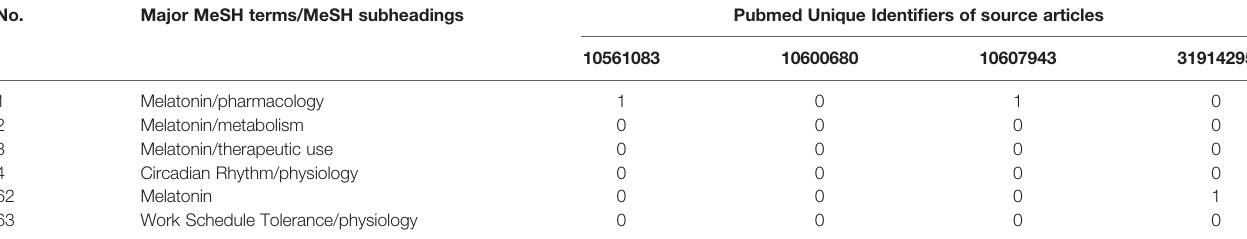
TABLE 4 | Highly frequent major MeSH terms/MeSH subheadings -source articles matrix (localized). No.